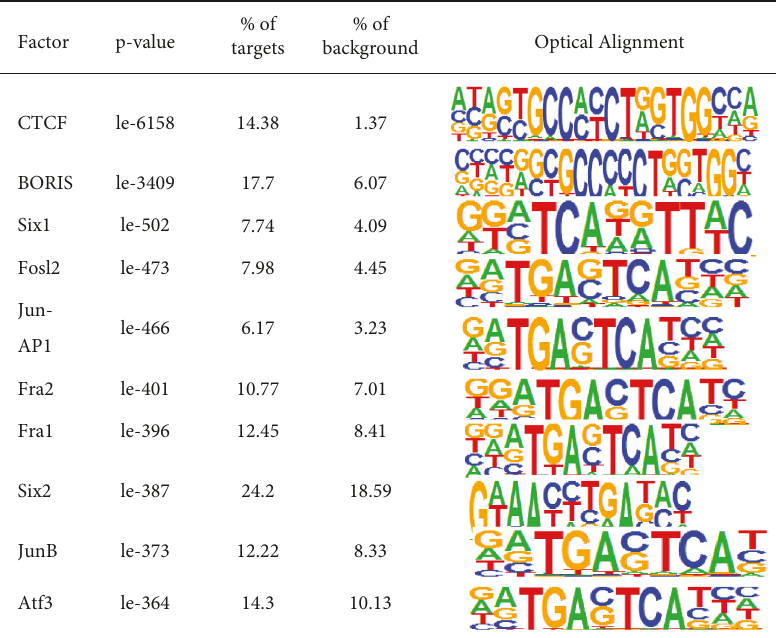
Table 2: Motif analysis of chromatin open region in 293T